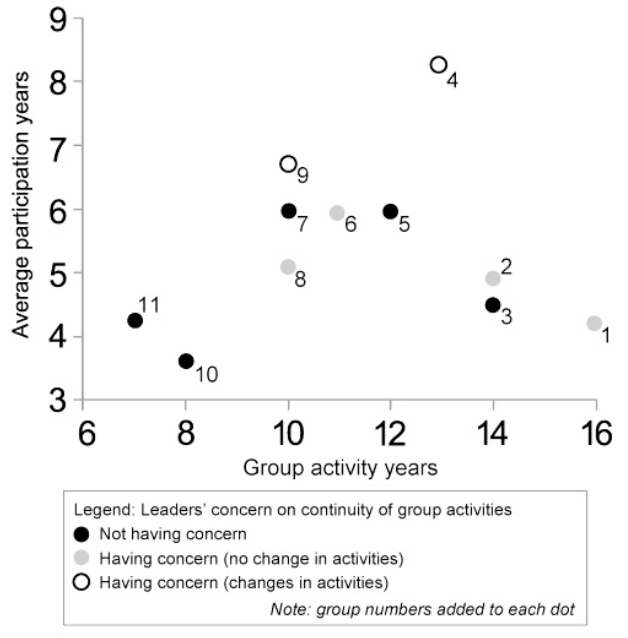
Fig. 3 . Concerns relating to the continuity of group